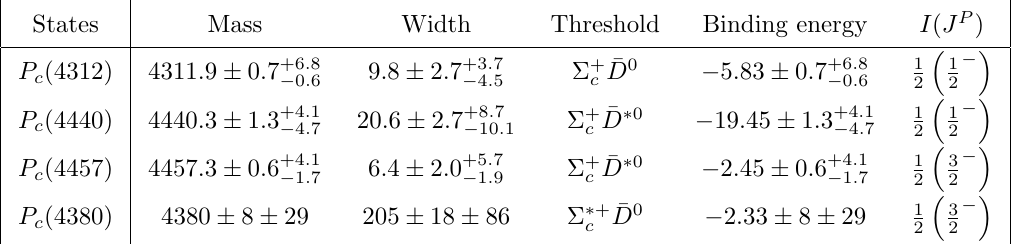
Table 1 . The experimental and theoretical information of the P c (4312), P c (4440), P c (4457) [10], and P c (4380)